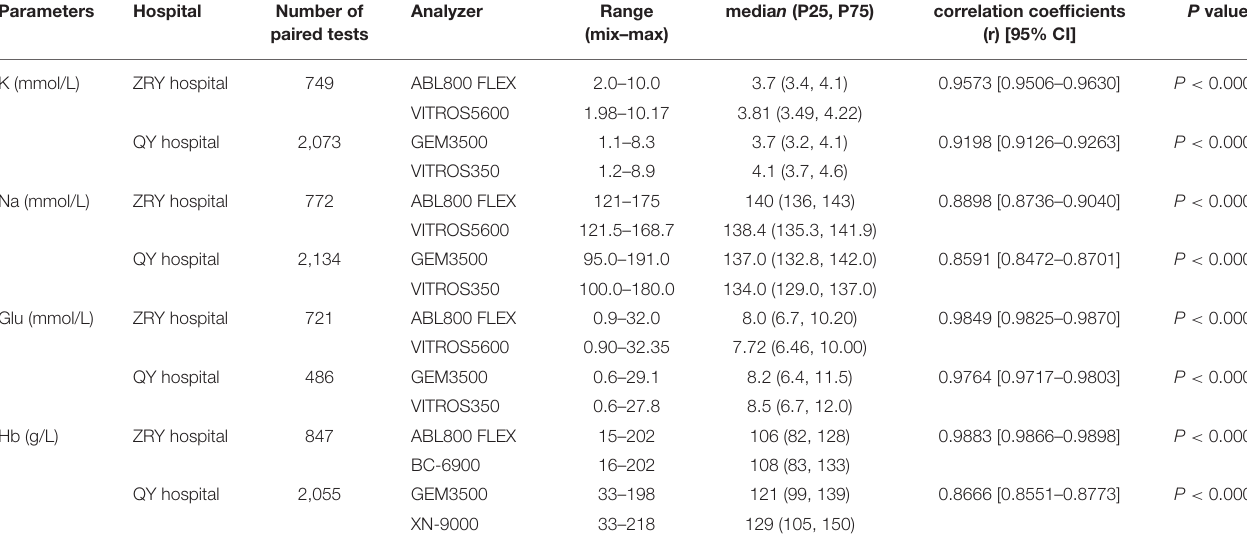
TABLE 1 | Potassium, sodium, glucose, and hemoglobin levels measured by blood gas, dry chemistry, and complete blood count analyzers at the study sites.